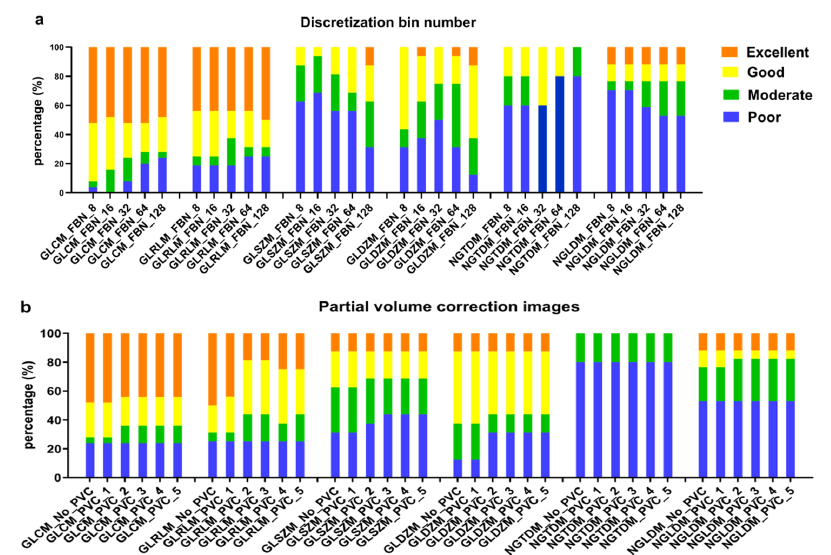
Figure 9. Agreement of each features families between different aggregations methods from: ( a ) original SUV image discretized with FBN from 8 to 128, and ( b ) original SUV and PVC images (with FWHM from 1 to 5) discretized with FBN = 128. The relative distributions of the overall ICC value of texture features per ICC category are shown (ICC > 0.9: excellent, 0.75 ≤ ICC < 0.9: good, 0.5 ≤ ICC < 0.75: moderate, ICC < 0.5: poor).